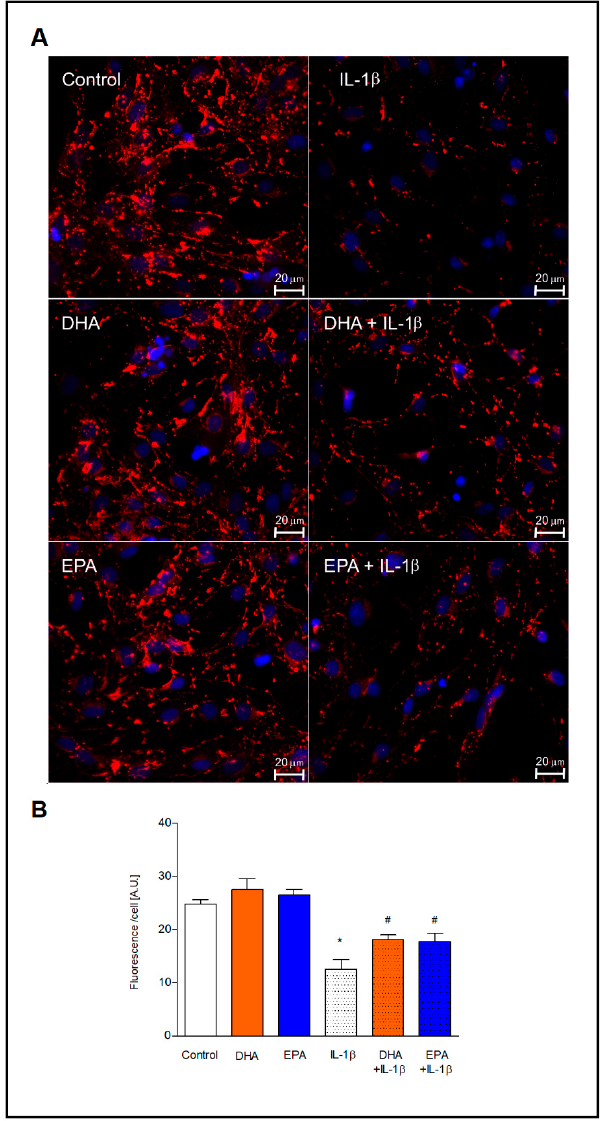
Figure 5. Expression of connexin 43 in astrocytes. ( A ) Representative fluorescence images depicting the double immunostaining of connexin 43 (red) with DAPI (blue). The cells were incubated with 30 µM of DHA and EPA for 24 h and then treated with 10 ng/mL 1L-1 β for 16 h. ( B ) Quantification of the immunofluorescence signal in the cells. The number of cells in the field was counted and an average fluorescence intensity value per cell was calculated * p < 0.001 compared to unstimulated control cells, # p < 0.05 compared to IL-1 β -treated cells.